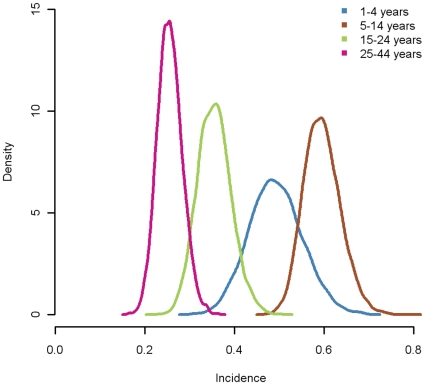
Posterior distribution of the cumulated incidences.Estimated cumulated incidence distributions for age-groups 1–4, 5–14, 15–24, 25–44 years during the second wave.